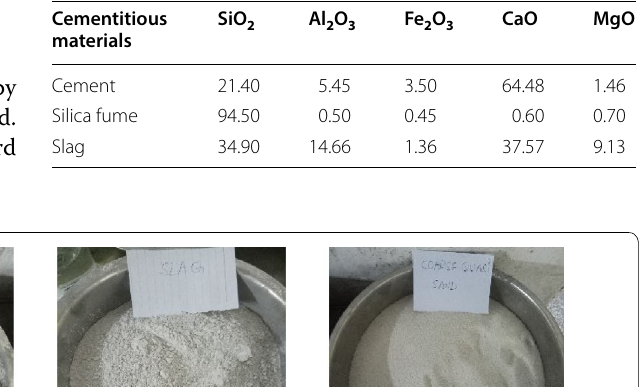
Table 1 Chemical composition of cement, silica fume and slag in